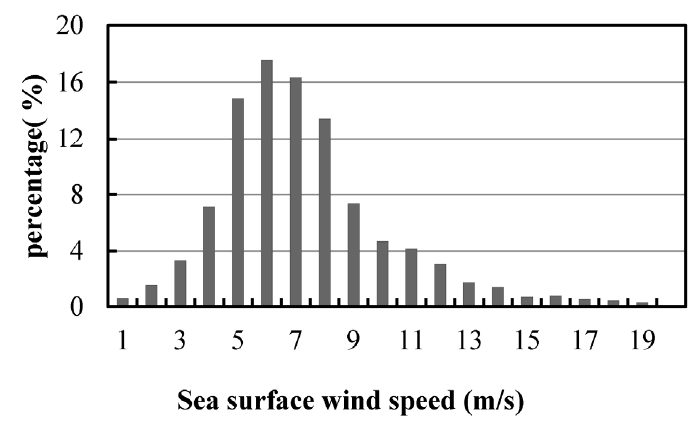
Figure 3. Histogram of the ECMWF ERA-Interim reanalysis wind speeds collocated with the X-SAR